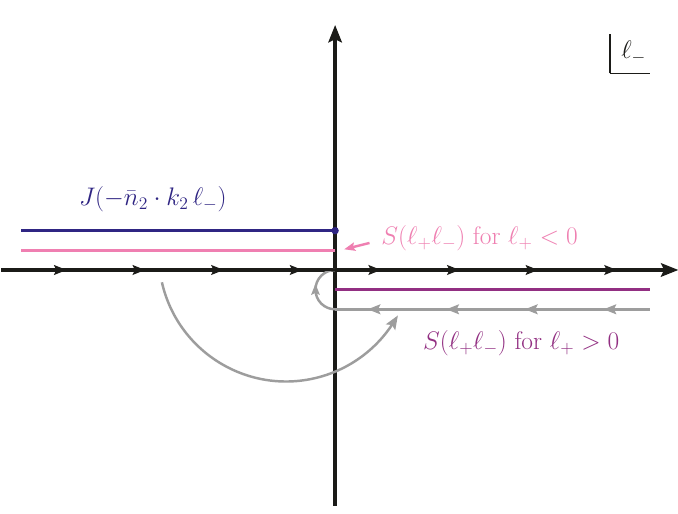
Figure 5 . Singularities of the integral (2.29) in the complex ‘ (cid:0)